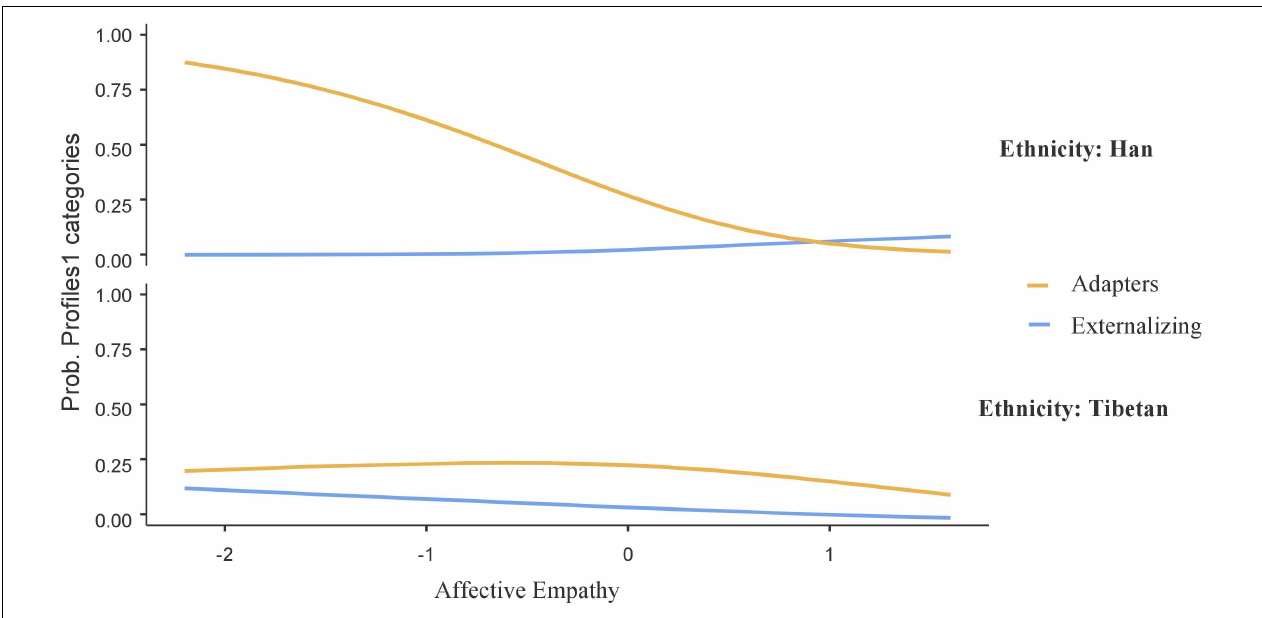
FIGURE 2 | Interaction effect of affective empathy and ethnicity on probability of adaptive and externalizing profiles. N =